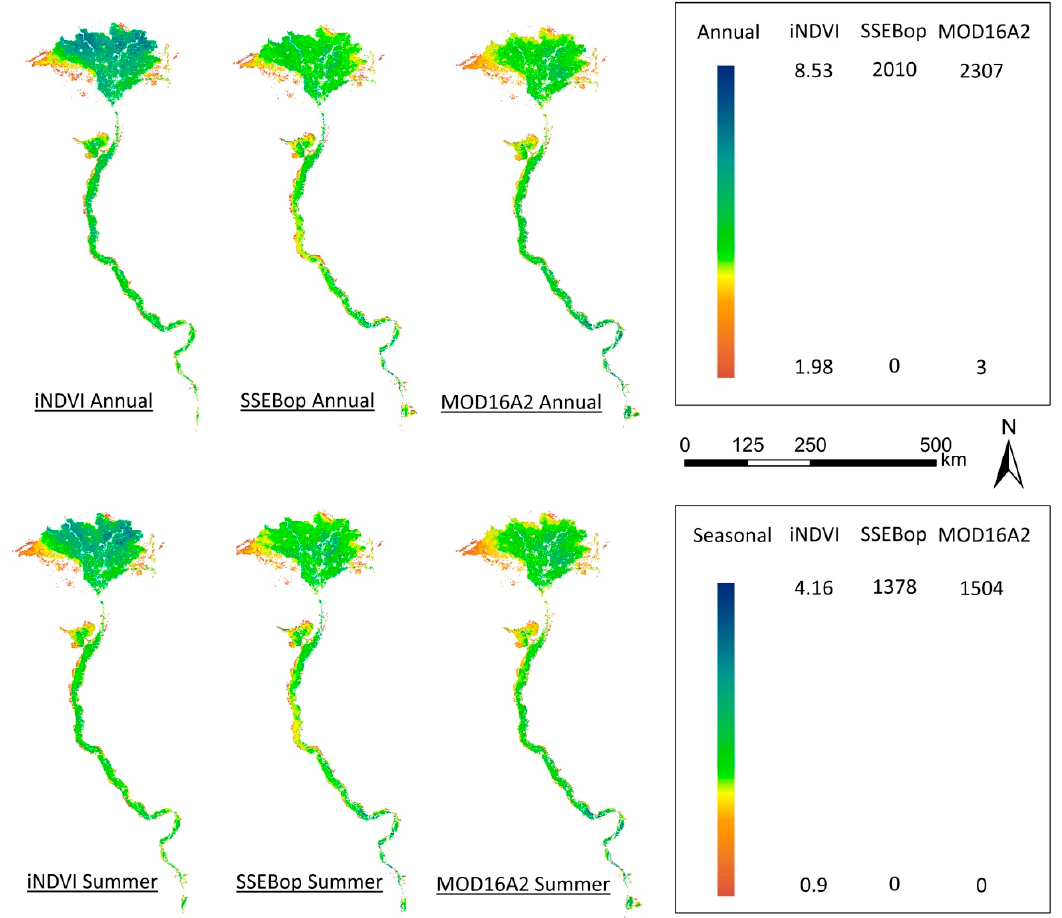
Figure 6. The average annual and seasonal ETa from the SSEBop and MOD16A2 products against the iNDVI over agricultural areas in the Nile Delta and Valley from 2005 to 2010.